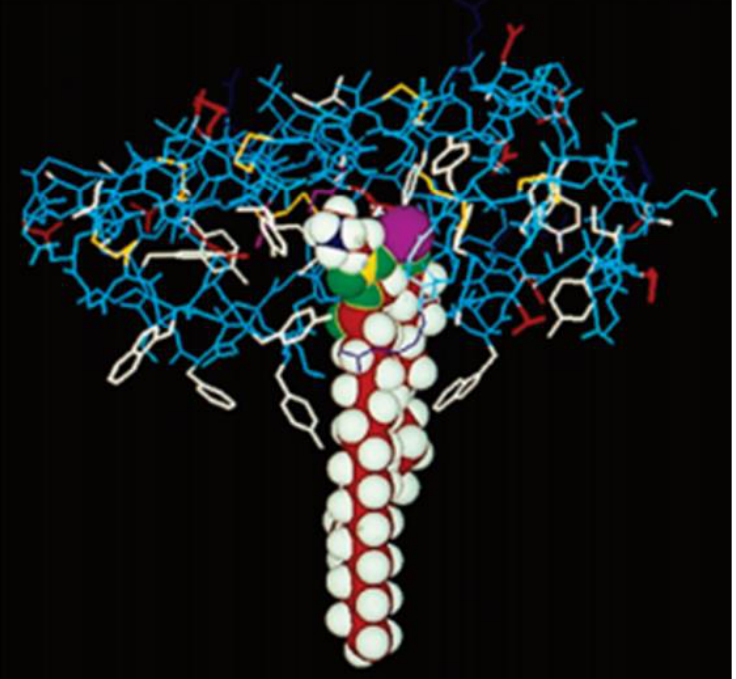
Figure 5. Cartoon depicting the X-ray crystal structure of cobra venom sPLA2 (wireframe) with dimyristoyl phosphatidylethanolamine (shown in a space-filling model) bound to it. The active site dyad His48/Asp99 and the Ca 2+ ion are depicted together as a purple sphere. The aromatic interfacial residues Phe-5, Trp-19, Tyr-52 and Tyr-69 of PLA2 are shown in white. These residues of the enzyme are reaching as deep as 9 – 10 carbons in the acyl chain of the fatty acid while the rest of the chain is submerged into the lipid bilayer. Reprinted with permission from [21]. Copyright 1994, Elsevier.